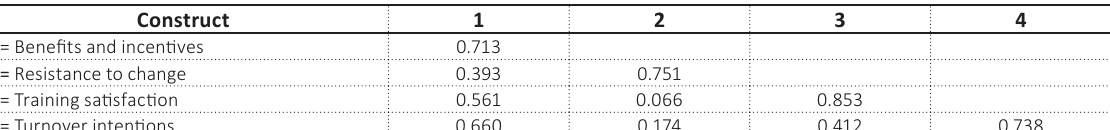
Source: Authors’ elaboration.